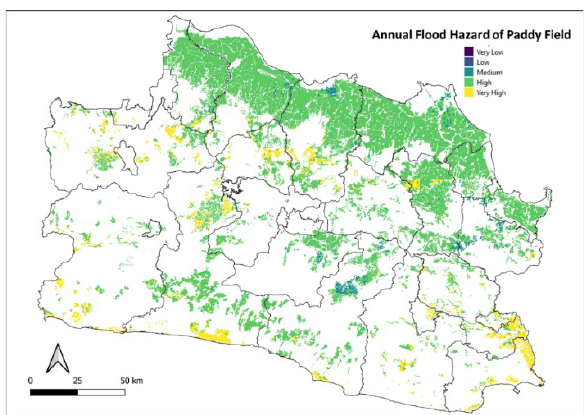
Figure 5 . Flood hazard model in the rice fields in 2021